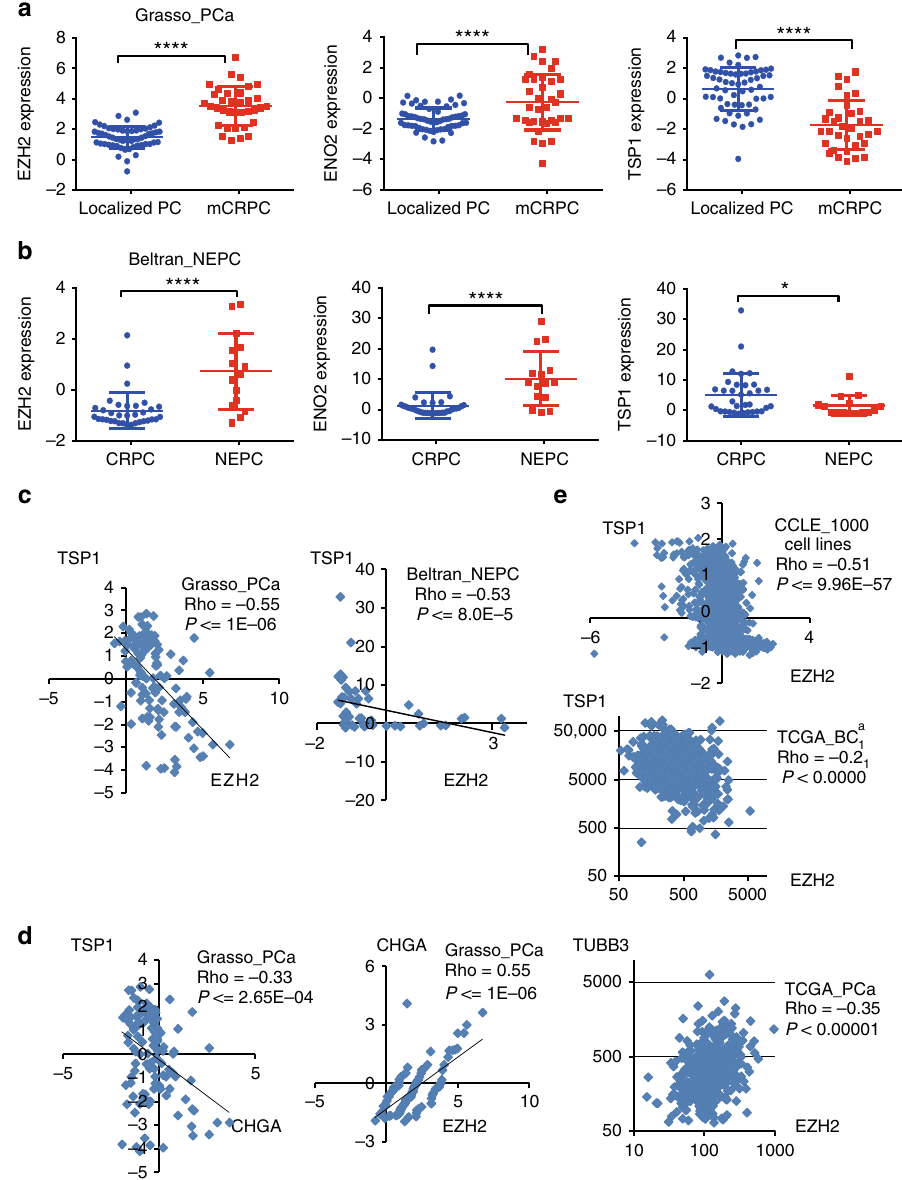
Fig. 6 TSP1 expression is downregulated and negatively correlates with EZH2 and NE markers in NEPC. a Expression of EZH2 and ENO2 is higher ( P = 1.78E-11, P = 1.6E-3, respectively), while TSP1 expression is lower ( P = 1.0E-9), in metastatic CRPCs than in untreated localized prostate cancers (Grasso_PCa). b Expression of EZH2 and ENO2 is higher ( P = 2.95E-4, P = 1.4E-3, respectively), while TSP1 expression is lower ( P = 0.017), in NEPC than in adenocarcinoma CRPCs (Beltran_NEPC). P values are from unpaired two-tailed Student ’ s t test. All values are mean ± standard deviation. **** P ≤ 0.0001. * P ≤ 0.05. c Negative correlation of TSP1 and EZH2 expression in the Grasso_PCa and Beltran_NEPC datasets. d The expression of NE marker CHGA is negatively and positively correlated with TSP1 and EZH2, respectively, in localized PCa and metastatic CRPC in Grasso_PCa data. In addition, EZH2 expression positively correlates with that of another NE marker TUBB3 in TCGA prostate cancer dataset. e Negative correlation of TSP1 and EZH2 expression in the 1000 Cancer Cell Line Encyclopedia (CCLE) dataset and TCGA breast cancer dataset. Spearman Correlation Coef fi cient Rho and associated P values were indicated for each scatter plots. Additional results from patient samples are in Supplementary Fig. 3 and